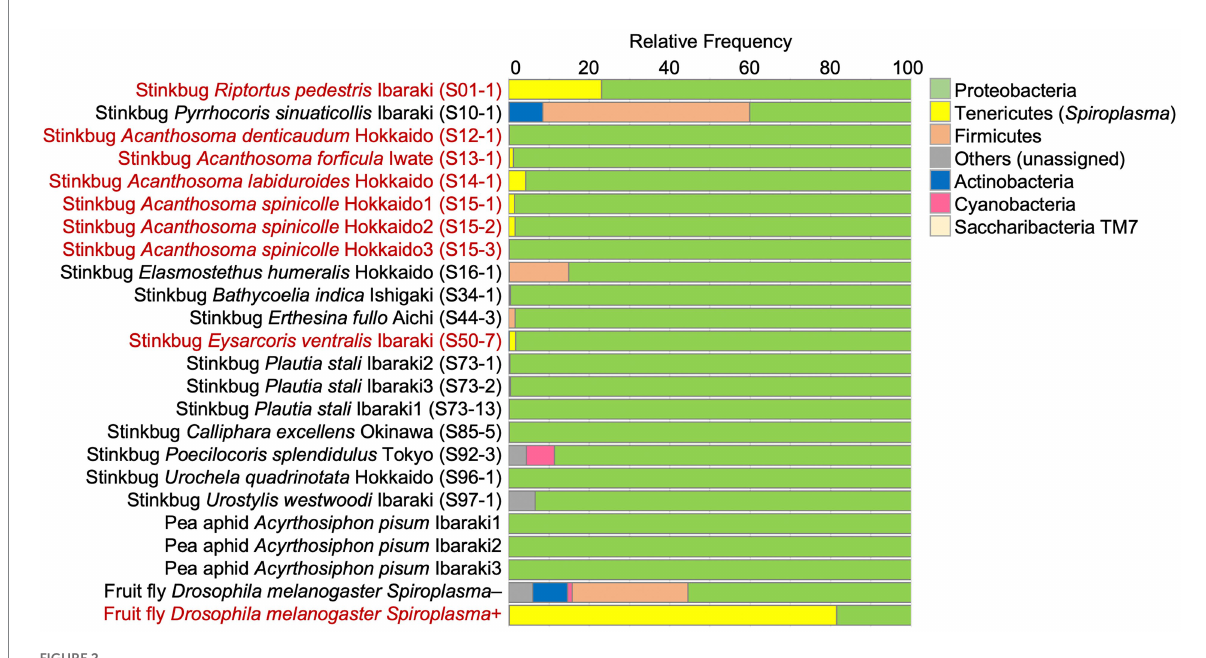
FIGURE 2 The relative abundance of the top seven bacterial phyla detected from stinkbugs and other insects by 16S rRNA gene amplicon sequencing. The phylum Tenericutes (or Mycoplasmatota) corresponds to Spiroplasma. The insect names in red indicate Spiroplasma positive ones. Sample numbers are shown in parentheses (Supplementary Table